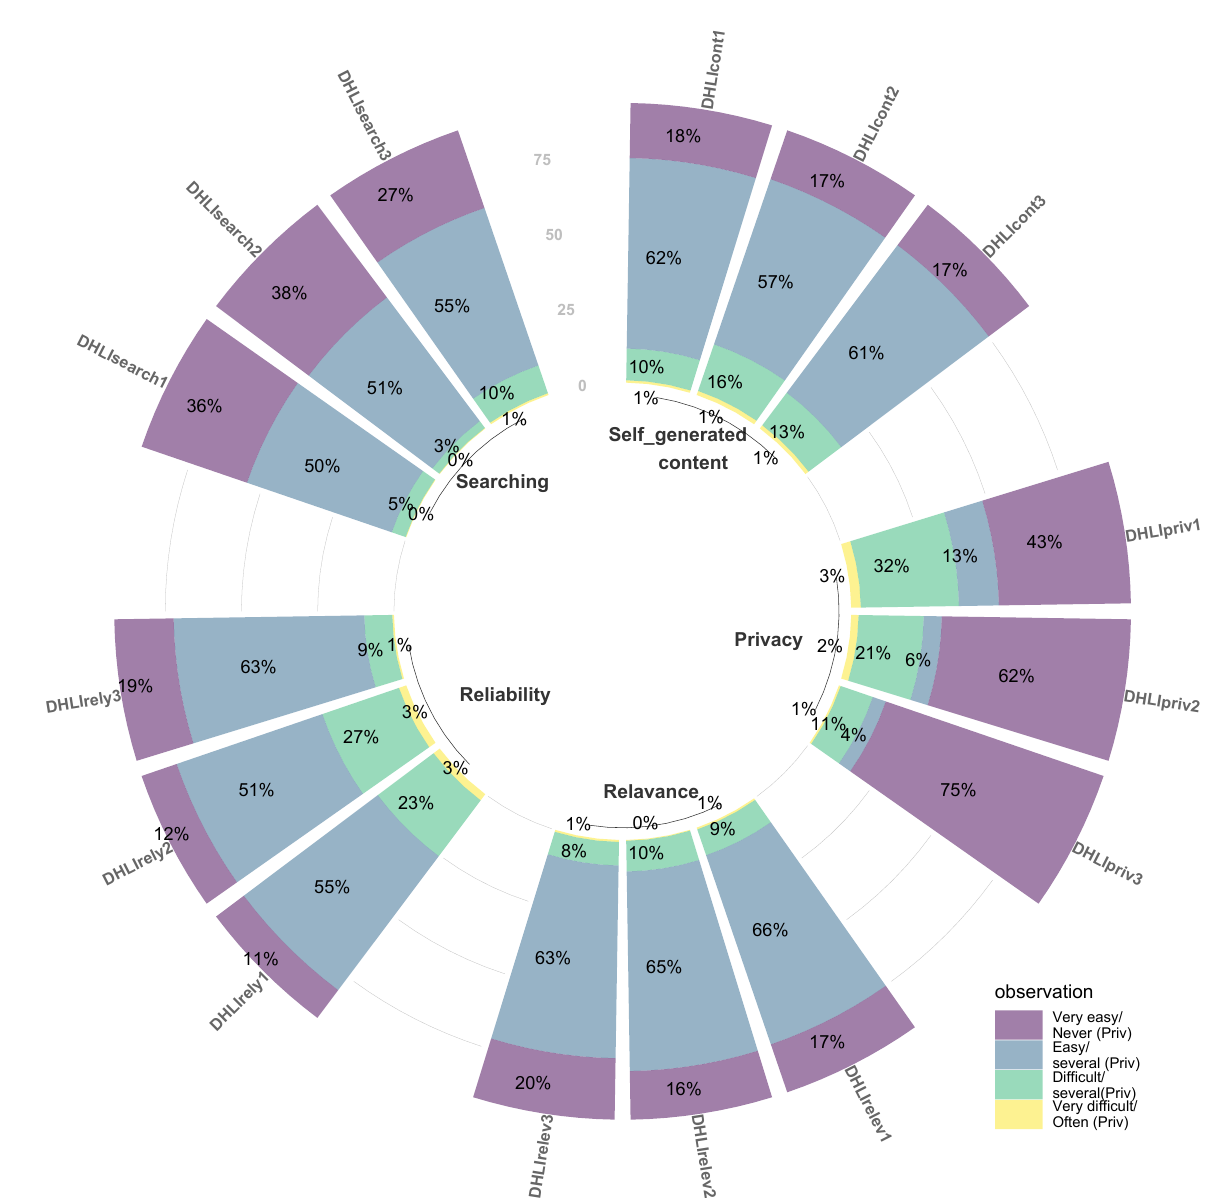
Figure 3. The distribution of digital health literacy (DHL) questions among Taiwanese